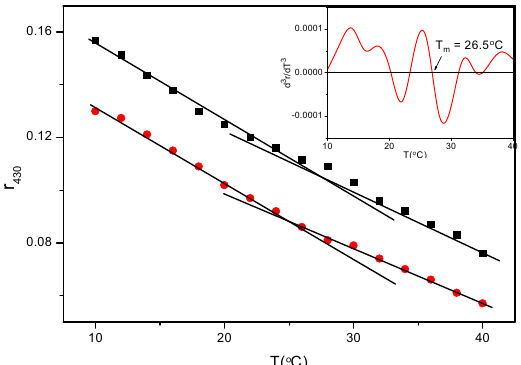
Figure 3. Fluorescence anisotropy at 430 nm ( r 430 ) of the DPH fluorescent probe against the temperature for the C 3 (C 16 His) 2 /DOPE-pDNA lipoplexes at an effective charge ratio ρ eff = 4 and two C 3 (C 16 His) 2 cationic lipid molar fractions ( ρ = 0.2 in red and α = 0.5 in black) in the C 3 (C 16 His) 2 /DOPE mixed lipid. The inset shows determination of the gel-to-fluid transition temperature (T m ) following the Phillips method. Errors are less than 3%.